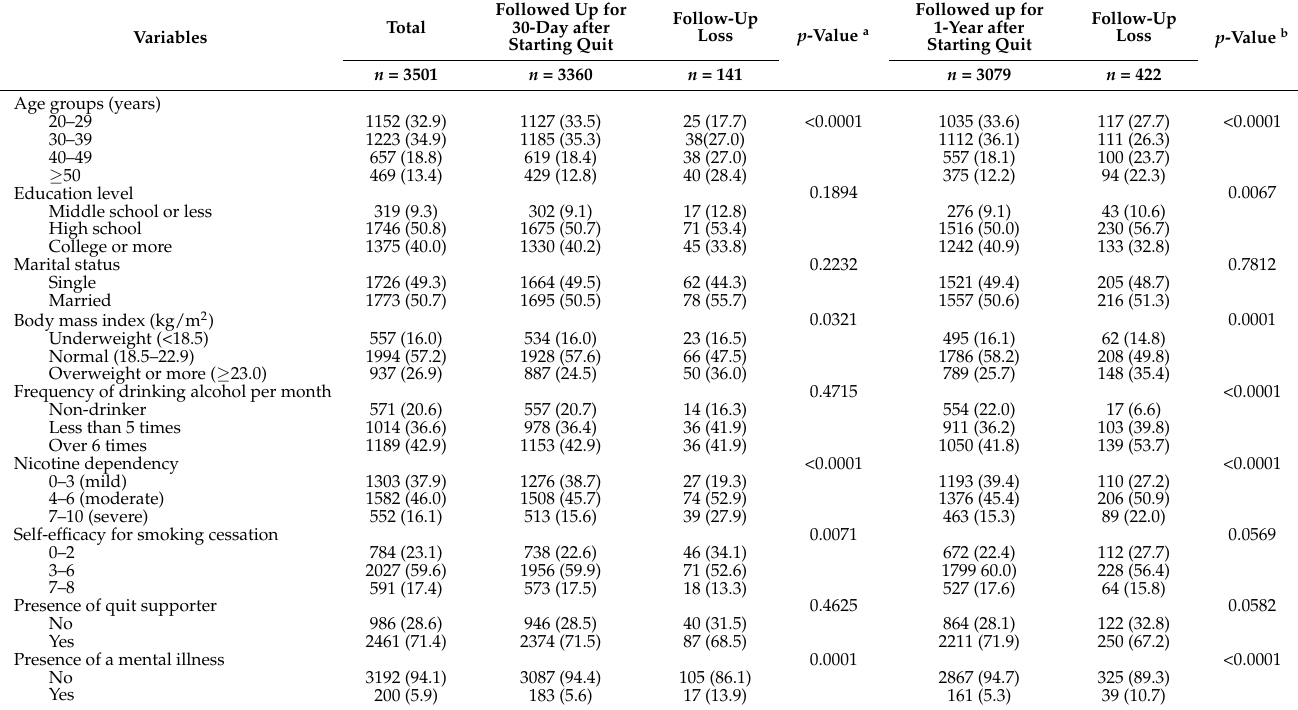
Table 1. Baseline characteristics of all woman smokers, at 30-days and 1-year follow-up, and those lost to follow-up.